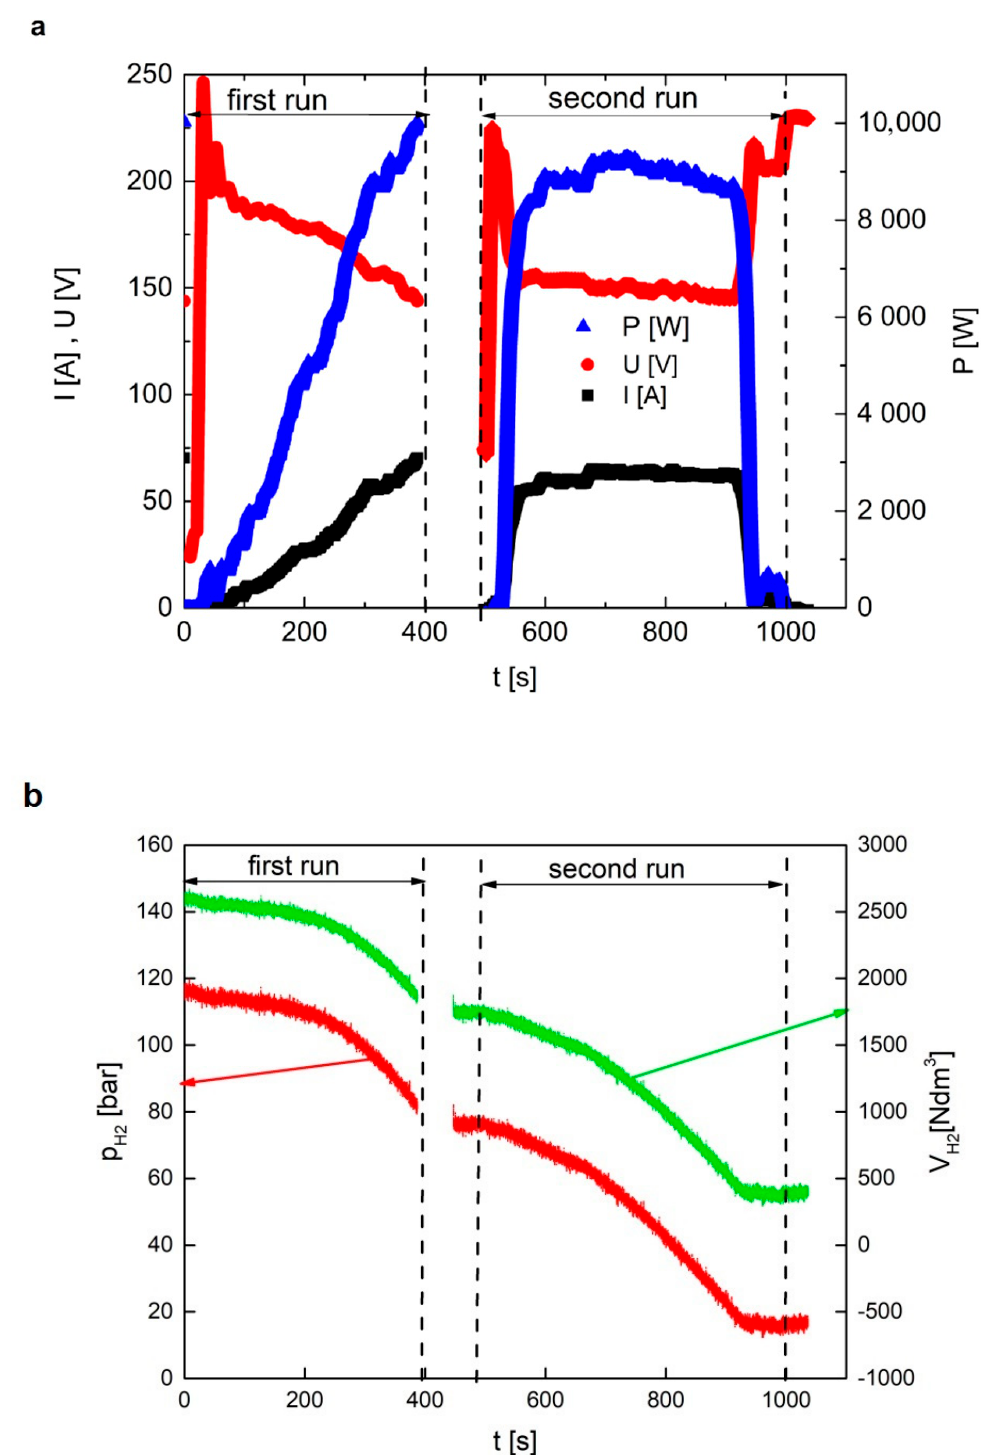
Figure 14. ( a ) Variation in voltage (U), current (I), and power (P) of the PEMFC stack vs. time, recorded during operation under variable electrical load. ( b ) Variation in hydrogen pressure (P H2 ) as volume of hydrogen vs. time, monitored during PEMFC operation.